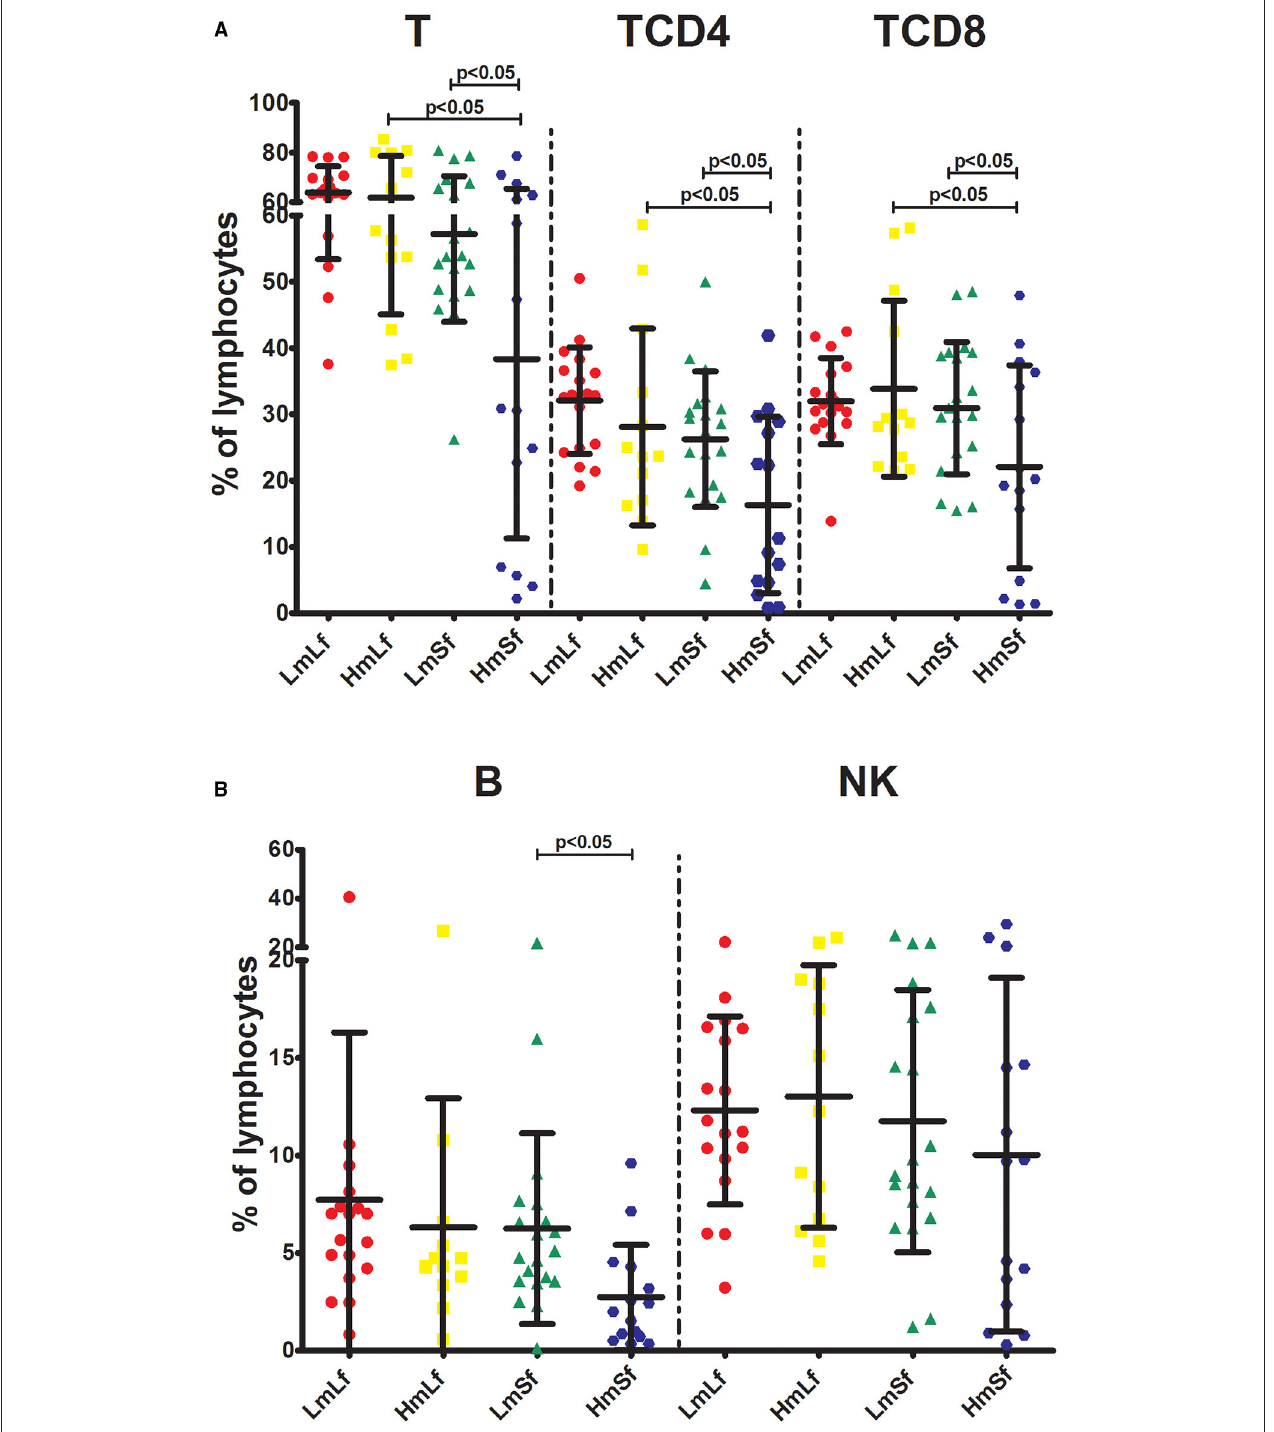
FIGURE 2 | Effects of the MELD score and the follow-up period on the percentages of lymphocyte subpopulations following liver transplantation. Comparison of the percentages of T, TCD4, and TCD8 (A) , B and NK (B) among LmLf ( n = 18), HmLf ( n = 13), LmSf ( n = 20), and HmSf ( n = 15). Bars represent mean and SD. MELD, model for end-stage liver disease; T, CD3 + T cells; TCD4, CD3 + CD4 + T cells; TCD8, CD3 + CD8 + T cells; B, CD19 + B cells; NK, CD56 + CD16 + natural killer cells; LmLf, low MELD score ( < 10) and long-term follow-up (28 days − 3 months); HmSf, high MELD score ( ≥ 20) and short-term follow-up ( < 28 days); HmLf, high MELD score and long-term follow-up; LmSf, low MELD score and short-term follow-up.